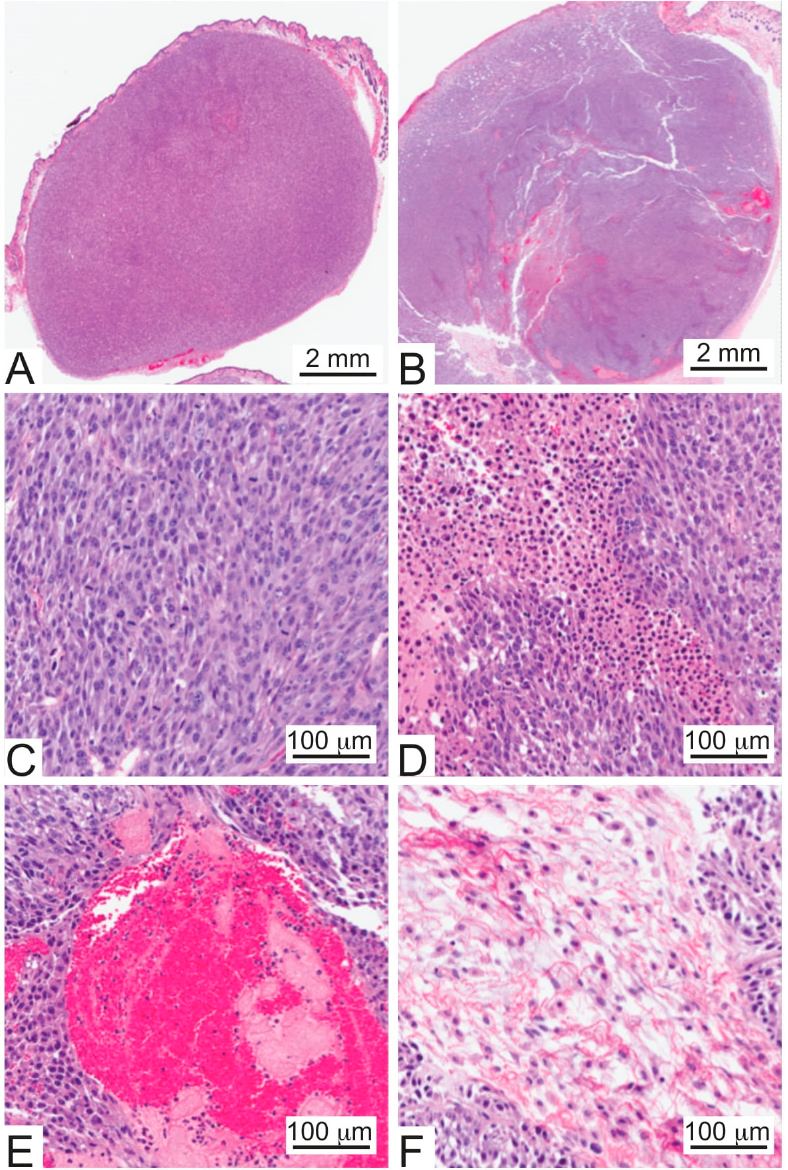
Figure 3. Representative histology of U87 MG and U87 MG/HNR xenograft tumors. Low magnification (1 × ) of representative tumors derived from ( A ) U87 MG parental and ( B ) U87 MG/HNR cells. ( C ) High magnification (20 × ) of a U87 MG/HNR tumor illustrating frequent mitotic figures. ( D ) High magnification (20 × ) of a U87 MG/HNR tumor showing regions of necrosis. ( E ) High magnification of a U87 MG/HNR tumor (20 × ) showing an example of a blood pool. ( F ) High magnification (20 × ) of a U87 MG/HNR tumor with an area of serous accumulation and poorly-organized extracellular matrix